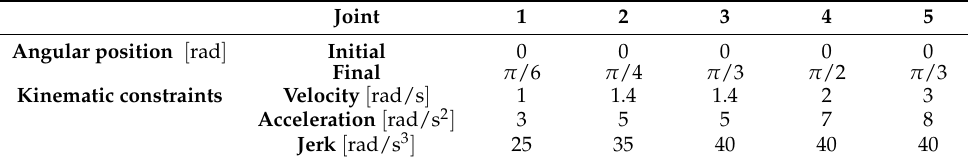
Table 3. Desired positions and kinematic motion limits of the robot’s joints.